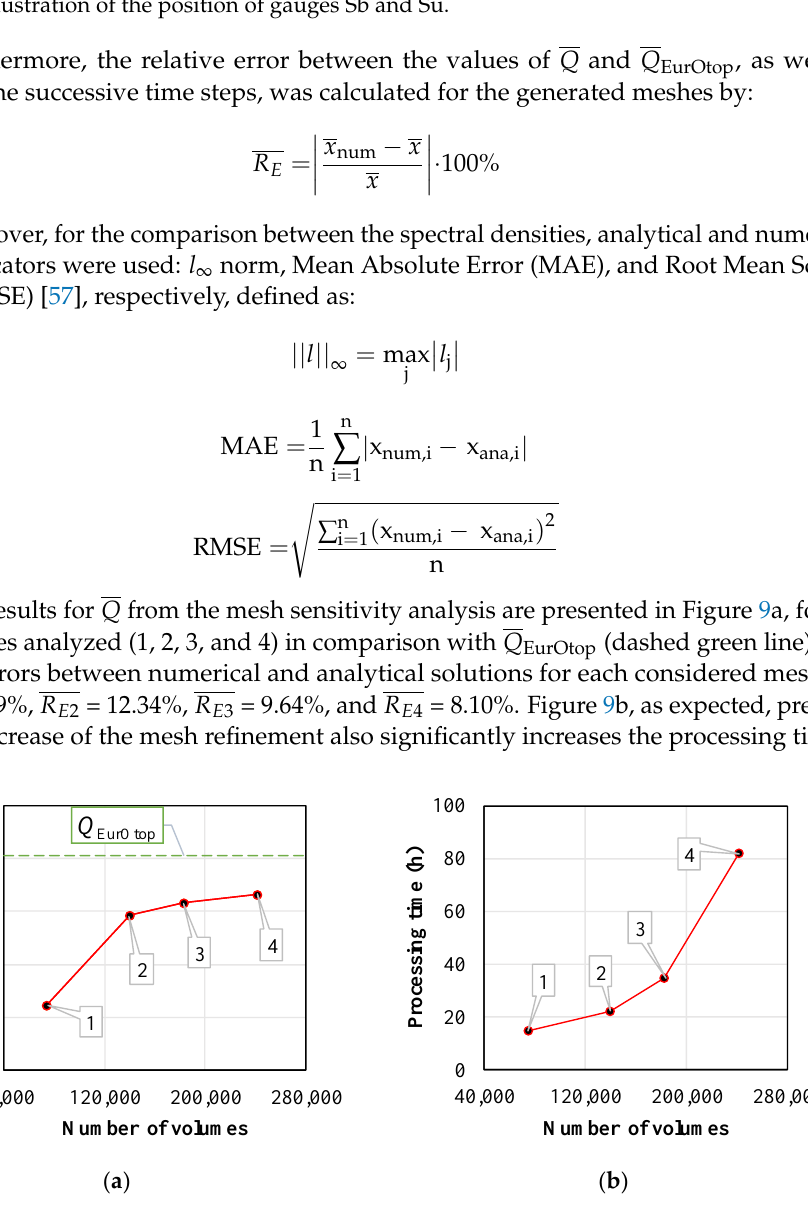
Figure 8. Illustration of the position of gauges Sb and Su.